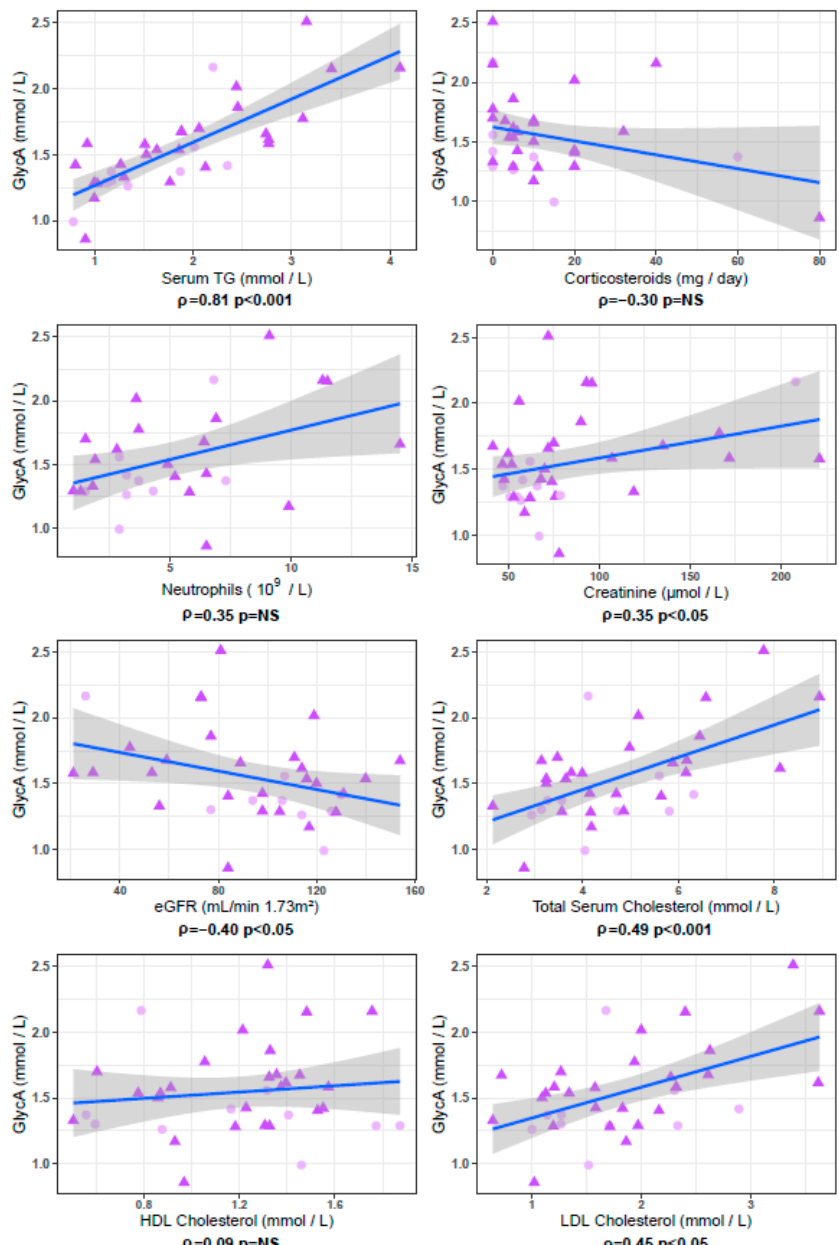
Figure 5. GlycA correlations in patients with lupus nephritis sampled at the time of renal biopsy. Below each panel, Spearman correlation coefficient ( ρ ) and p value are indicated. In the 36 samples collected at time of renal biopsy, originating from patients with non-proliferative (NonProlif LN, pink circles, n = 10) or proliferative (ProlifLN, purple triangles, n = 26) lupus nephritis, GlycA strongly correlates with serum TG, and correlates with total cholesterol and LDL cholesterol, but not with HDL cholesterol. GlycA shows significant association to serum creatinine levels and to estimated glomerular filtration rate (eGFR). Also depicted are two associations which do not reach statistical significance at a 0.05 threshold: a positive correlation of GlycA levels with neutrophil count ( p = 0.06) and an inverse correlation between GlycA and daily corticosteroid dosage ( p = 0.09). Full results are listed in Table 3.